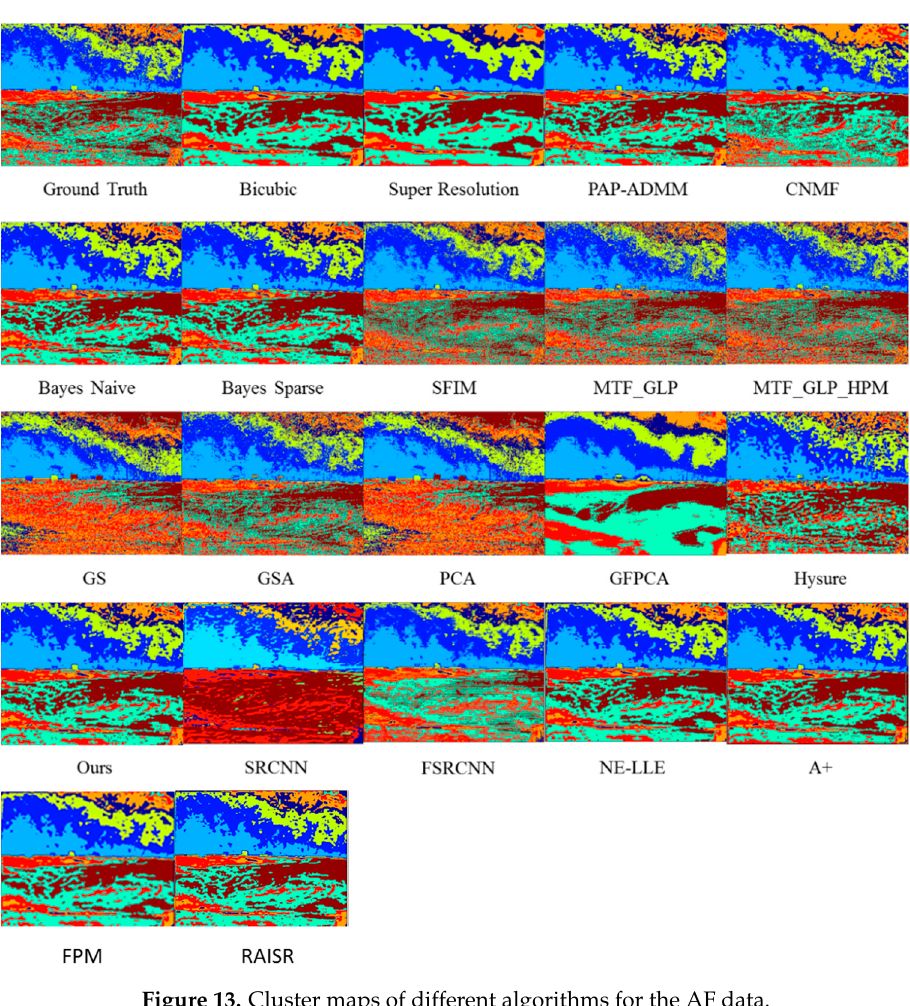
Figure 13. Cluster maps of different algorithms for the AF data.